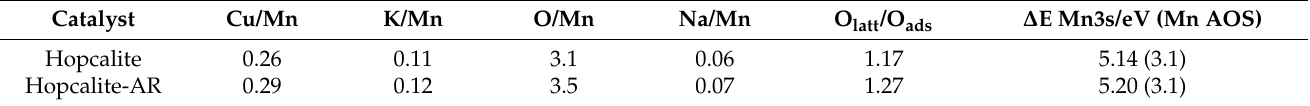
Table 7. XPS composition of the